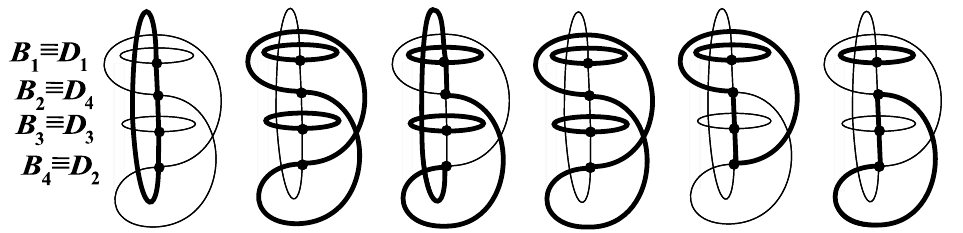
( 1 ) ( 1 ) has six 2-factors. 4